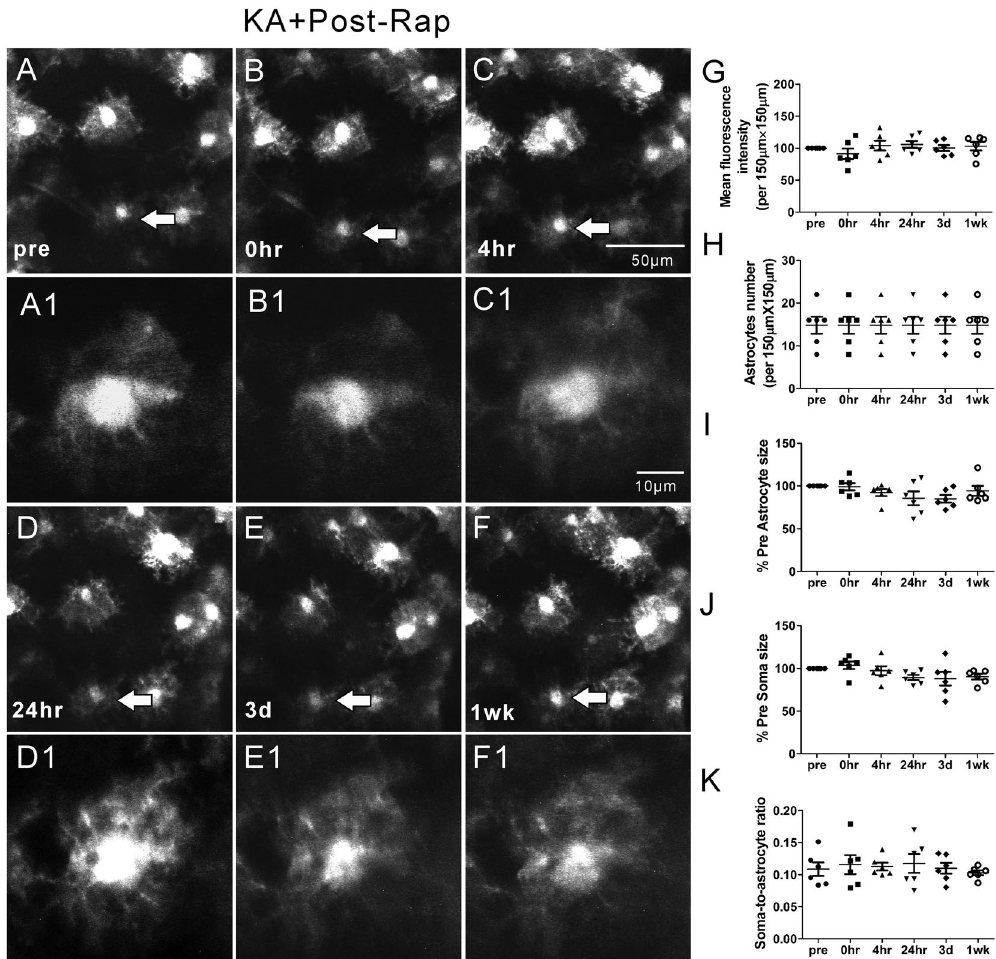
Figure 6. Representative in vivo images of astrocytes and quantitative analysis of astrocyte morphology features in the KA + Post-Rap group. With rapamycin post-treatment, most astrocytes present the similar bushy appearance with fine processes as pre-seizure’s condition. No obvious morphological change, vacuolization and astrogliosis were observed in most astrocytes ( A–F , A1–F1). Compared to pre-seizure condition, mean fluorescence intensity, astrocyte number, astrocyte size, soma size and soma-to-astrocyte ratio did not change over a one-week period ( G–K ) (n = 6; one-way ANOVA or Kruskal-Wallis test with Dunns post-test, p > 0.05). The arrows in the lower magnification images indicate the astrocytes displayed in the higher magnification